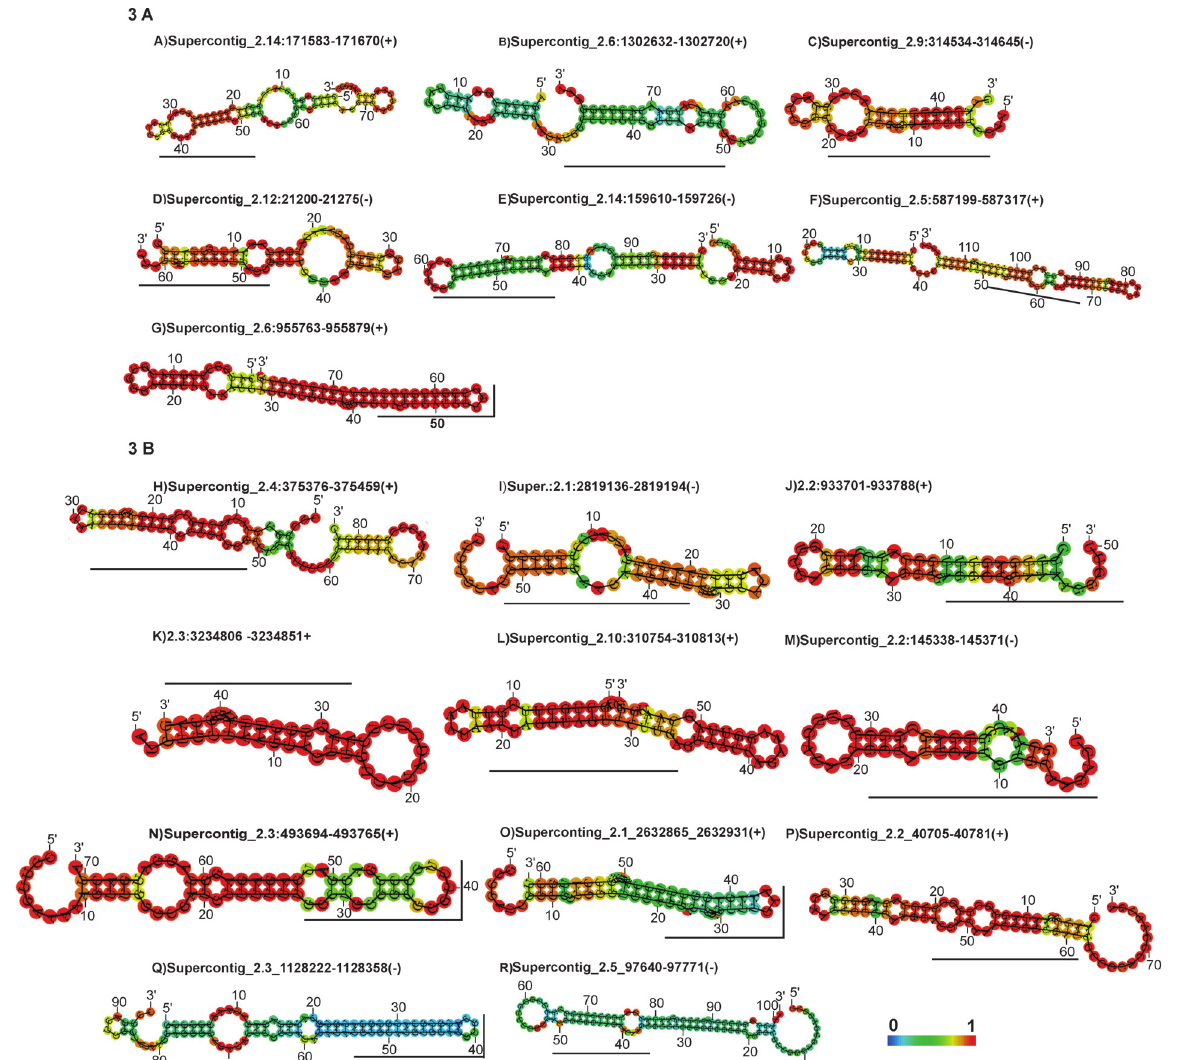
Figure 3 - Representation of the newly-identified potential pre-miRNAs in P. brasiliensis. The matured miRNA portion is highlighted in black bar. The structuresweregeneratedusingtheRfoldprogram.Theactualsizeoftheprecursorsmaybeslightlyshorterorlongerthanshowninthefigures.Thestruc- tures are colored according to the base pairing probabilities. Red color denotes high probability, as represented in the color